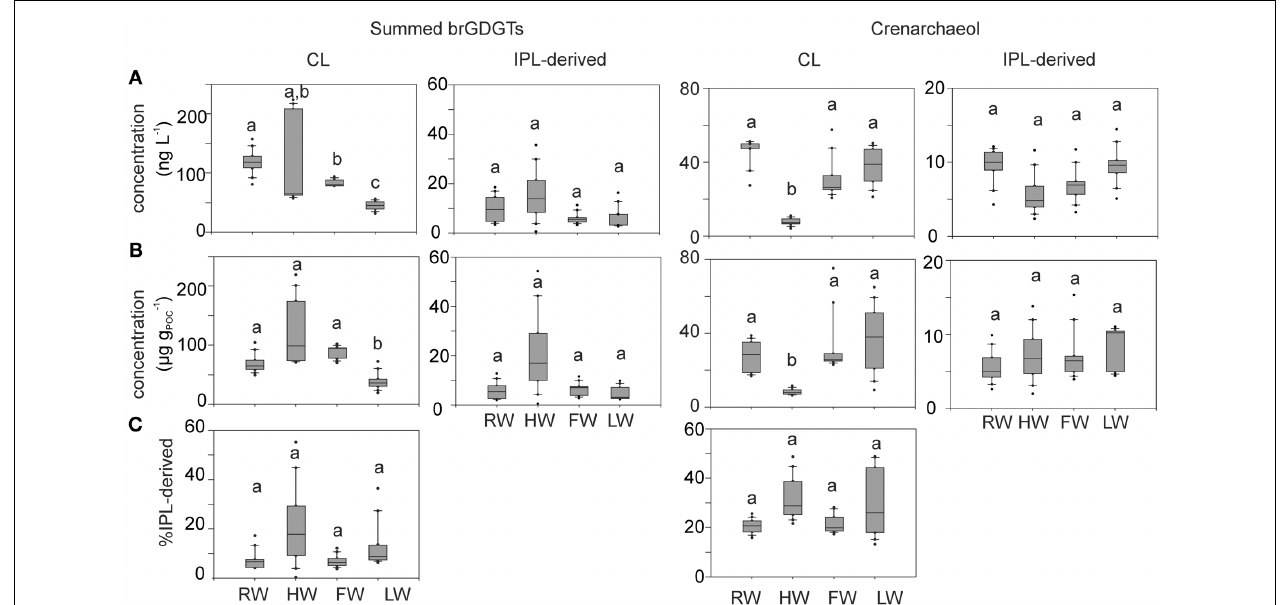
FIGURE 6 | Box plots of CL and IPL-derived summed brGDGT and crenarchaeol concentrations per liter (A) and normalized to POC (B) and the percentage of IPL-derived brGDGTs and crenarchaeol (C) in the